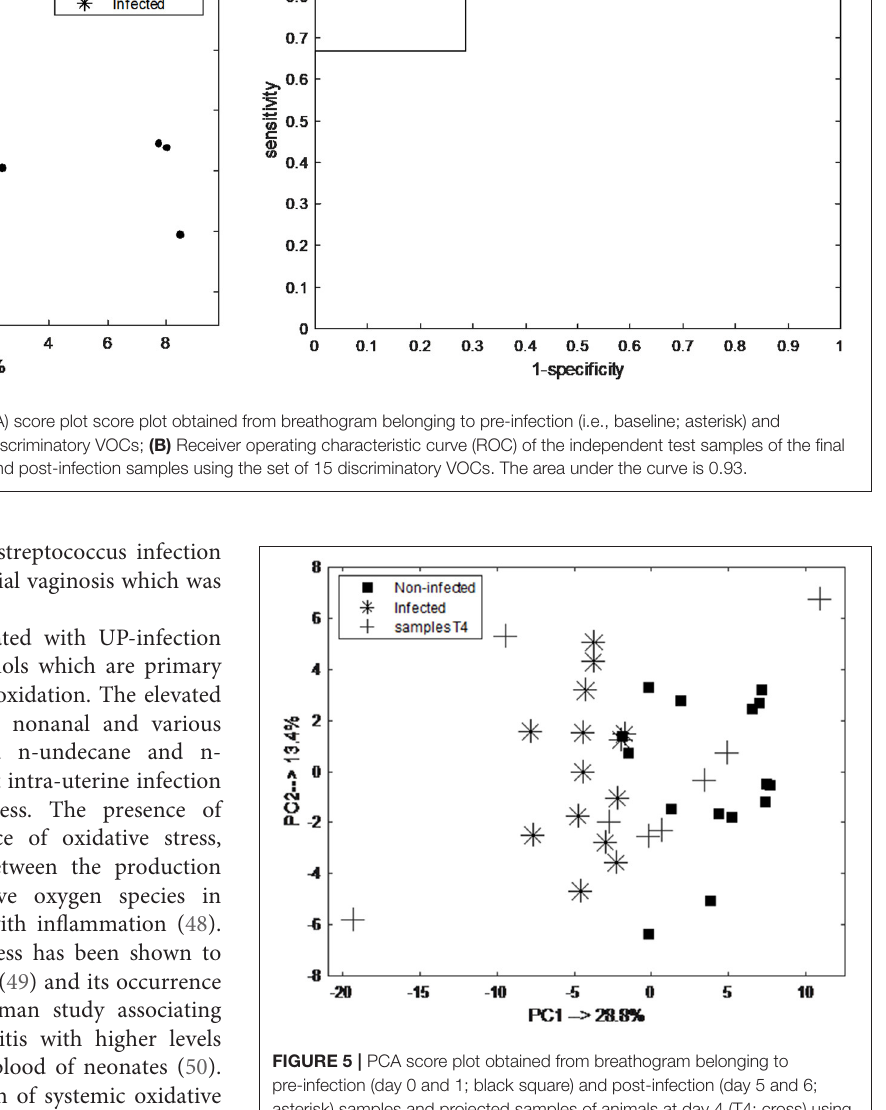
FIGURE 5 | PCA score plot obtained from breathogram belonging to pre-infection (day 0 and 1; black square) and post-infection (day 5 and 6; asterisk) samples and projected samples of animals at day 4 (T4; cross) using a set of 15 discriminatory VOCs. As can be seen majority of the samples are projected in the space belonging to the post-infection